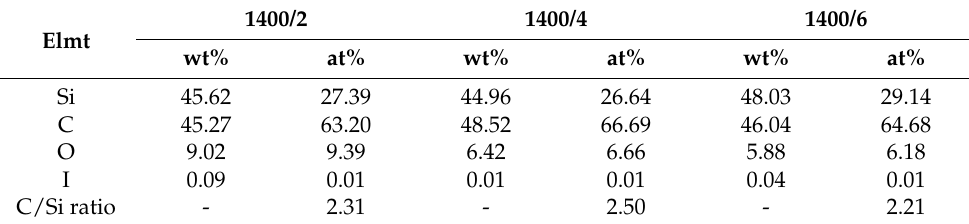
Table 1. EDS mapping of amorphous SiC fiber depending on the heat treatment time.